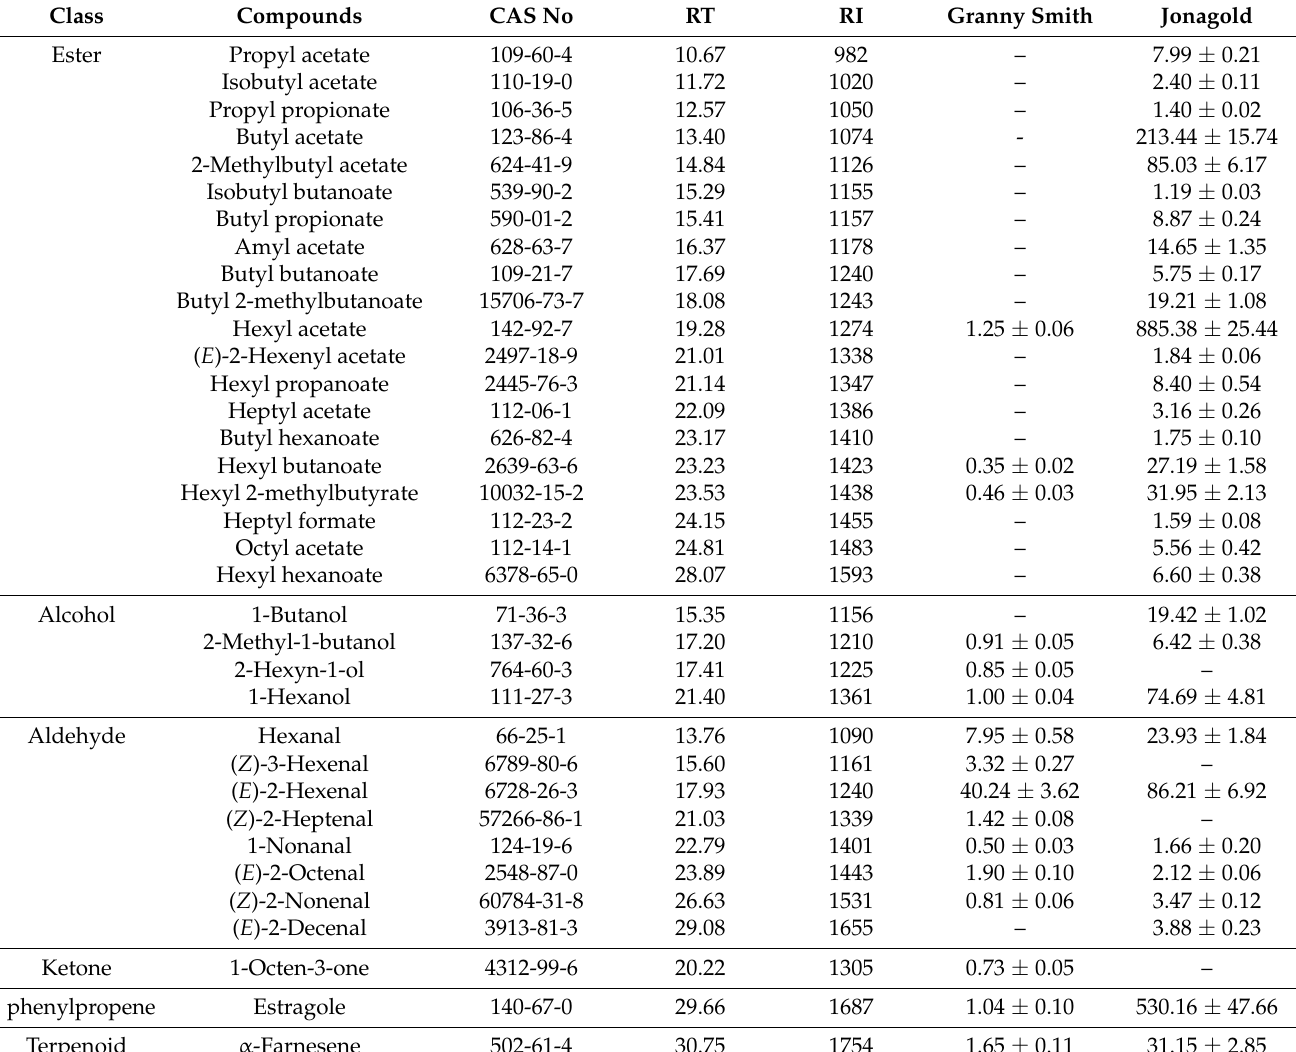
Table 2. The contents ( µ g/kg) of volatile compounds detected in Granny Smith and Jonagold